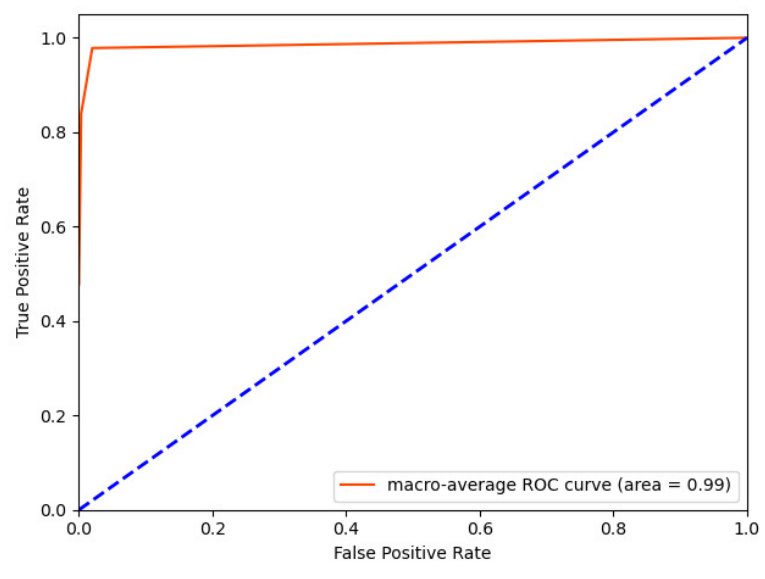
Figure 10. ROC curve of the proposed method on the test set with a training ratio is 80%.